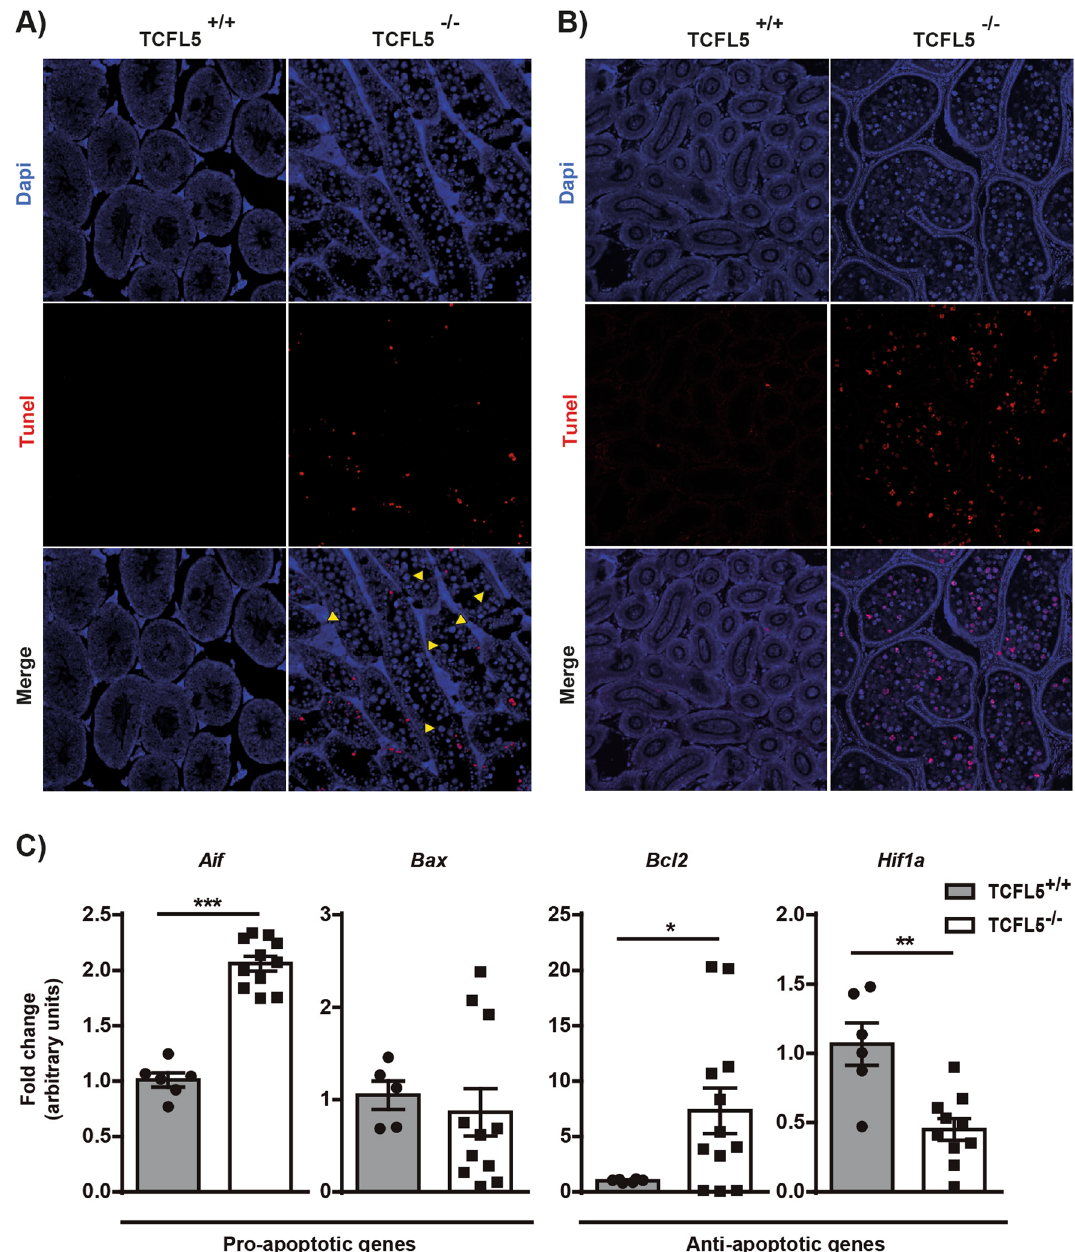
Figure 4. TCFL5 spermatocytes die in the epididymis. ( A ) TUNEL assay in seminiferous tubules cross-section of TCFL5 +/+ and TCFL5 −/− mice. Apoptotic cells (red) and nucleus (Dapi, Blue) were detected. TCFL5 −/− mice present apoptotic cells in the seminiferous tubules. Yellow arrows show the live multinucleated round giant cells. ( B ) TUNEL assay in epididymis cross-section of TCFL5 +/+ and TCFL5 −/− mice. Apoptotic cells (red) and nucleus (Dapi, Blue) were detected. TCFL5 −/− mice present apoptotic cells in the epididymis. ( C ) mRNA expression by qPCR of pro-apoptotic genes Aif and Bax , and anti-apoptotic genes Bcl2 , and Hif1a in TCFL5 +/+ and TCFL5 −/− mice. TCFL5 null mice present alterations in the expression of these genes. (n = 8), *p < 0.05, **p < 0.01, ***p <